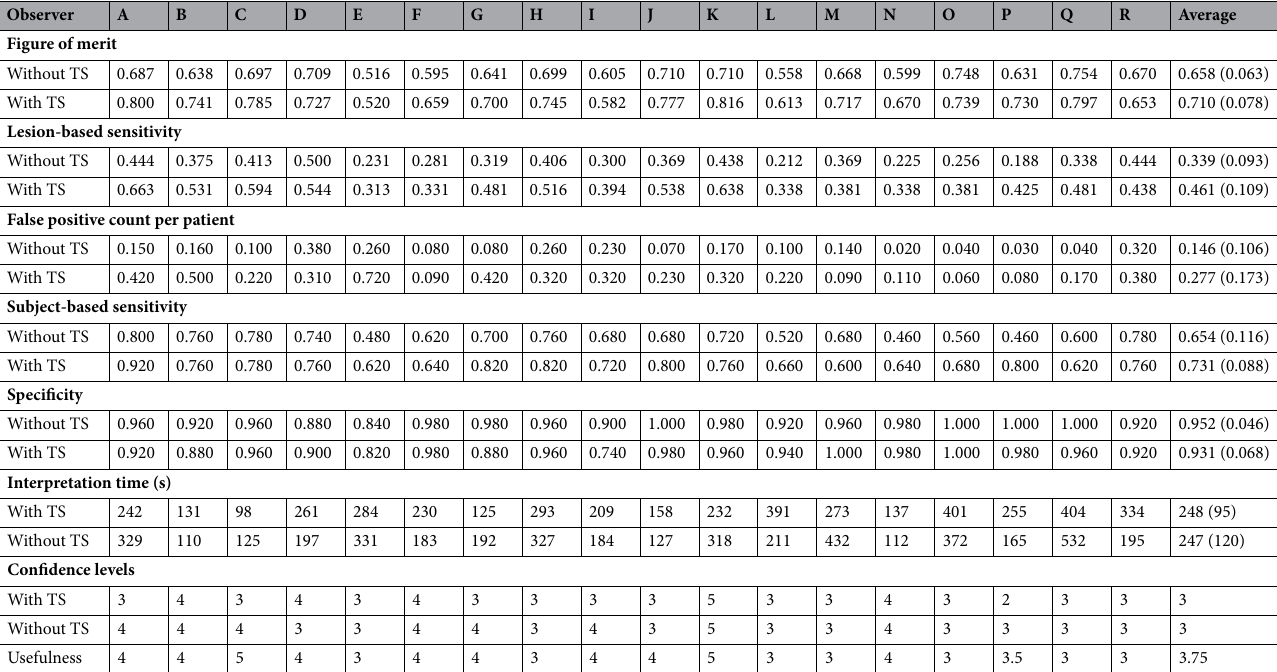
Table.3. Figure of merit, lesion-based sensitivity, false positive count per patient, subject-based sensitivity and specificity, interpretation time, and confidence level without and with TS, and usefulness ratings for observers across all subjects. Averages are mean (standard deviation) or median. Median is used in confidence levels and usefulness. Cells for which result is inferior in a comparison between without and with TS are bold. TS temporal